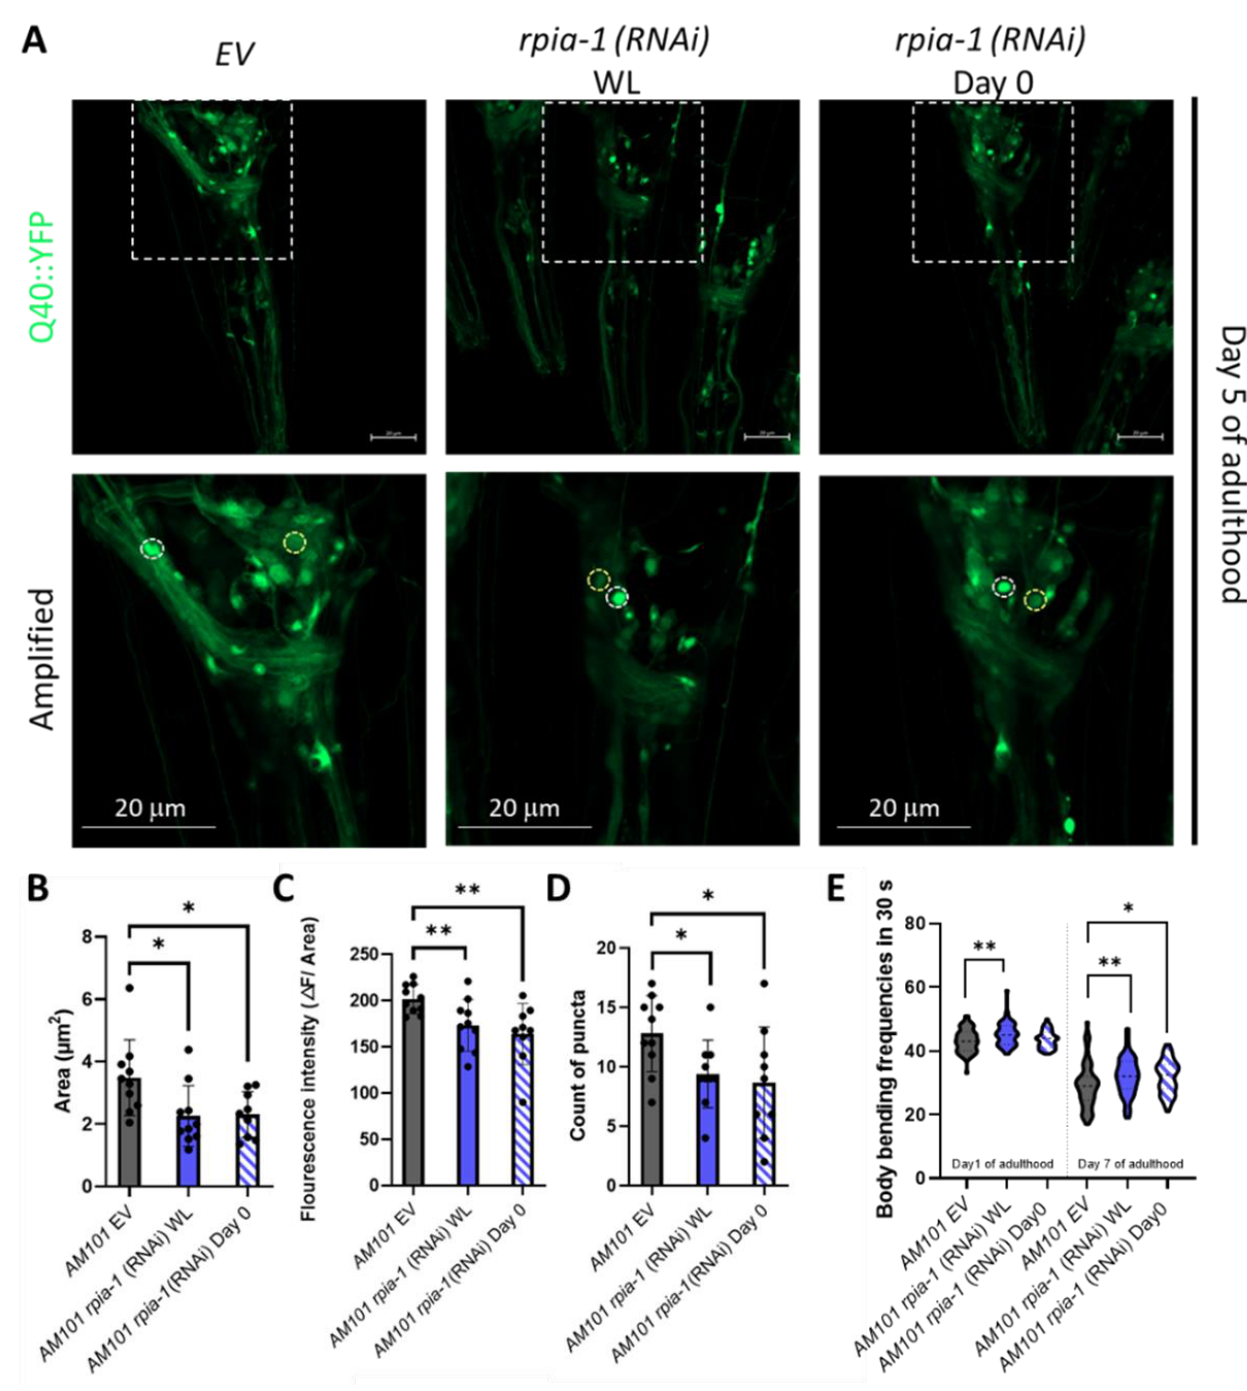
Figure 2. Knockdown of rpia-1 alleviates polyglutamine toxicity in neurons. ( A – D ) Knockdown of rpia-1 in neuronal polyQ pathogenesis model, AM101, initiated at the whole-life (WL) and at post-developmental stage (Day 0) both reduced puncta area, fluorescence intensity, and puncta count (*, p < 0.05; **, p < 0.01, by t -test). ( E ) The deteriorated body bending rate due to polyQ aggregation may be alleviated by knockdown of rpia-1 initiated the whole-life (WL) and at post-developmental stage (Day 0) (*, p < 0.05; **, p < 0.01, by t -test and ANOVA). Polyglutamine (polyQ) aggregation induces oxidative stress by elevating the levels of free radicals and eventually causes damage in the nervous system to trigger neurodegener- ation [34]. In addition, the inhibition of NADPH oxidase, which reduces the catalysis